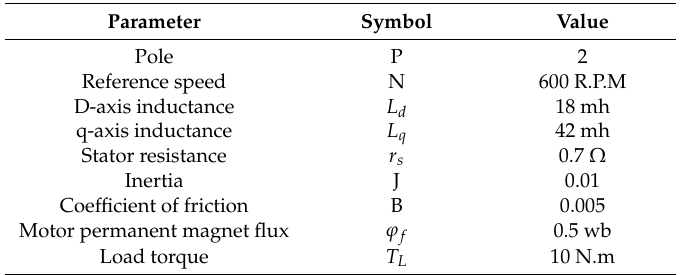
Table 1. Characteristics of five-phase permanent magnet motor.